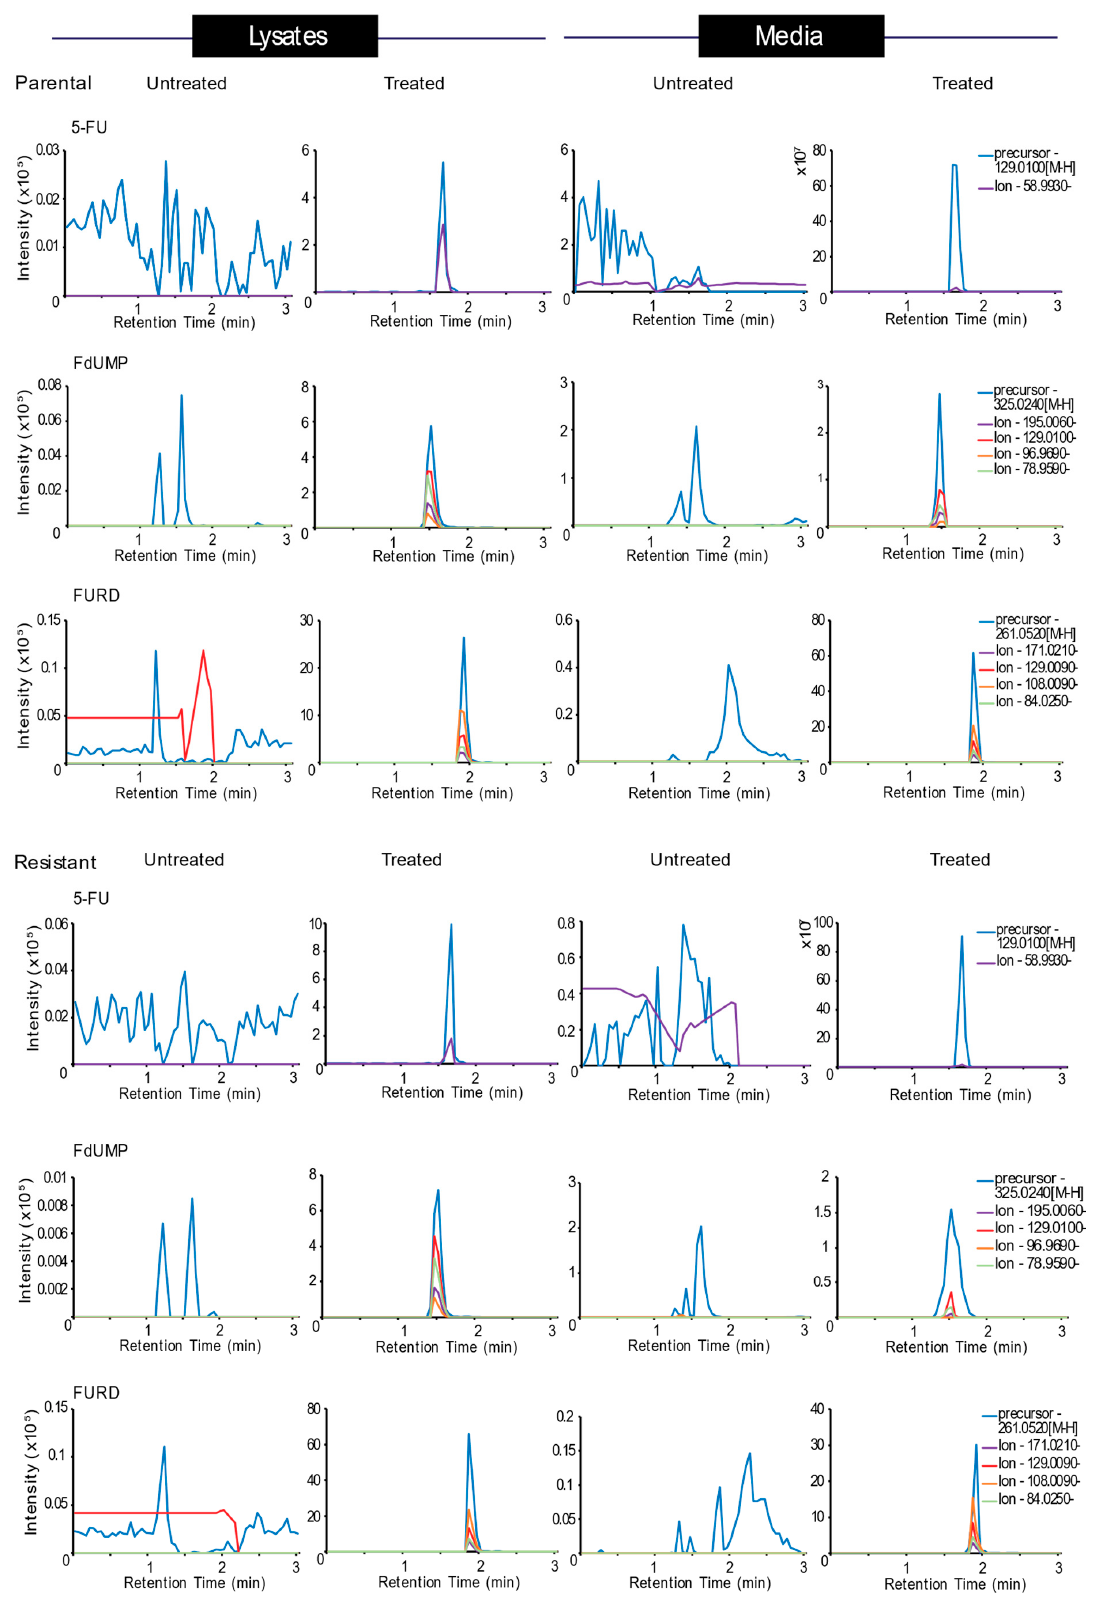
Figure 4. Relative quantitation of 5-FU and its metabolites.